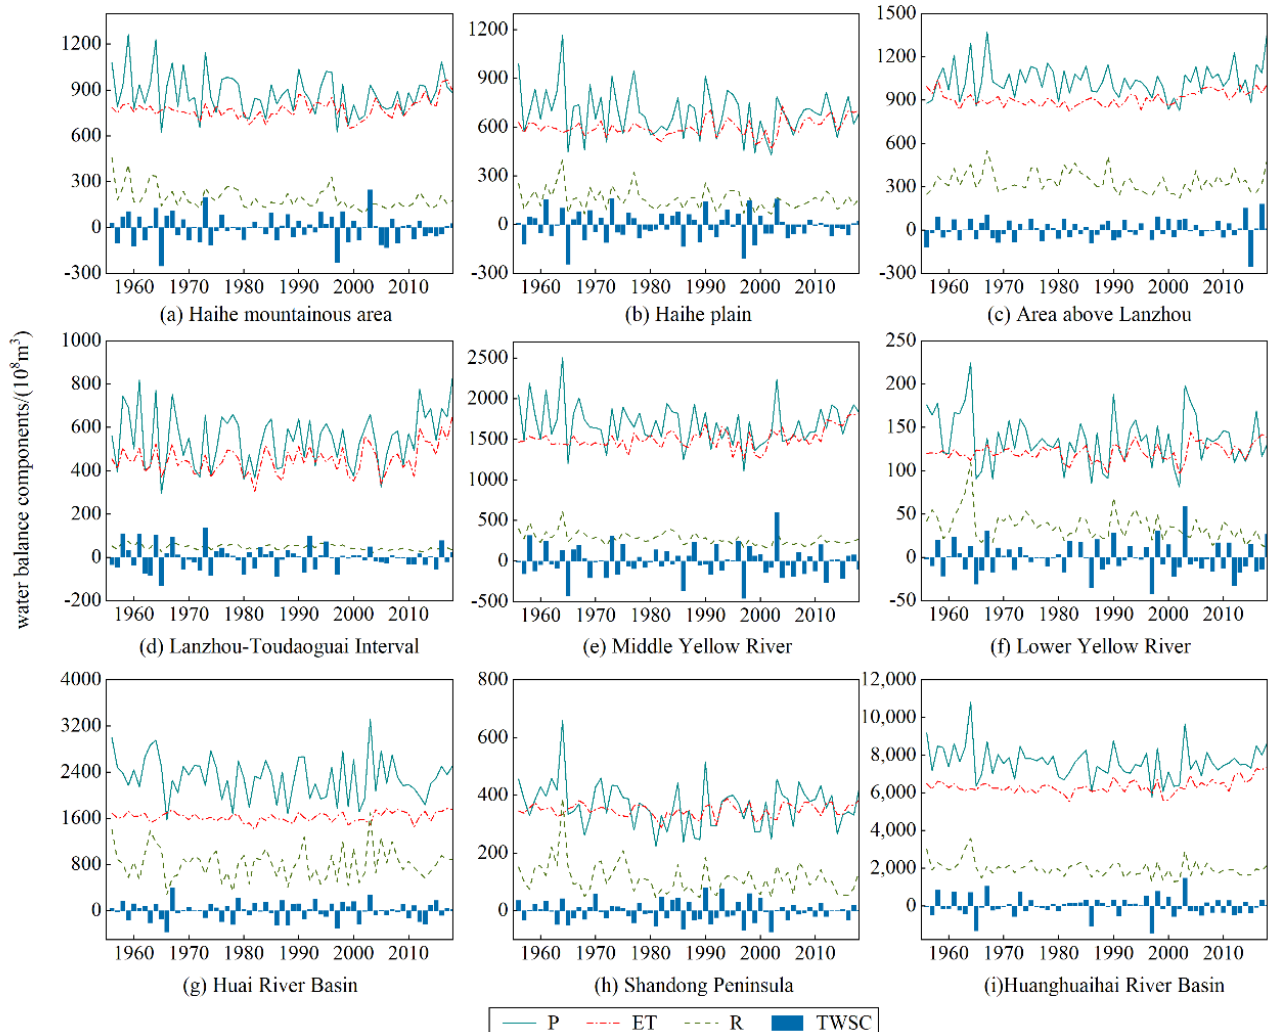
Figure 5. Evolution of water balance components in the HRB from 1956 to 2018. Figure 6 shows the temporal variation trend of water cycle elements in eight sub- regions of HRB, in which the precipitation in the Lanzhou-Toudaoguai Interval shows no significant upward trend, while the rest of the area shows a downward trend. The evaporation has a significant upward trend in the whole Yellow River Basin and Haihe Plain, but no significant change in other areas. The amount of surface water resources in Haihe mountainous area and plain, the middle and lower reaches of the Yellow River and Shandong Peninsula all show a significant downward trend, which show a significant upward trend in the area above Lanzhou and Haihe mountainous areas, and the change in TWSC is relatively smooth, embodied by the insignificant upward or downward